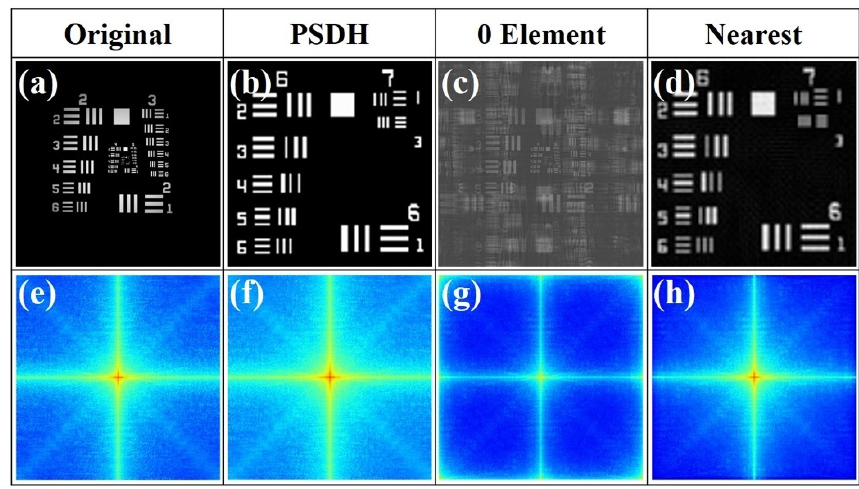
Figure 6. The simulated normalized reconstructed images of target with z = 29.059 mm by PSDH and PPSDH: ( a – d ) amplitude images and ( e – h ) Fourier spectral images of the original simulation target, PSDH, 0 element, and nearest-neighbor interpolation of PPSDH, respectively.